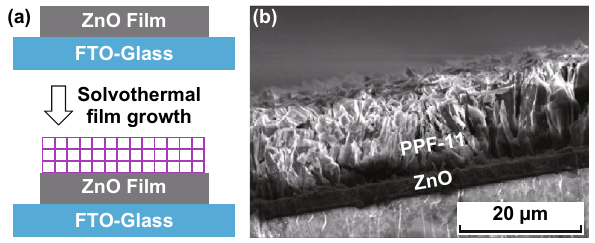
Fig. 31 a Schematic diagram of the solvothermal growth of PPF-11 film. b Cross-sectional-SEM images of solvothermally grown 10 μm thick PPF-11 film on ZnO layer. Reprinted with permission from Ref. [84]. Copyright 2019, American Chemical